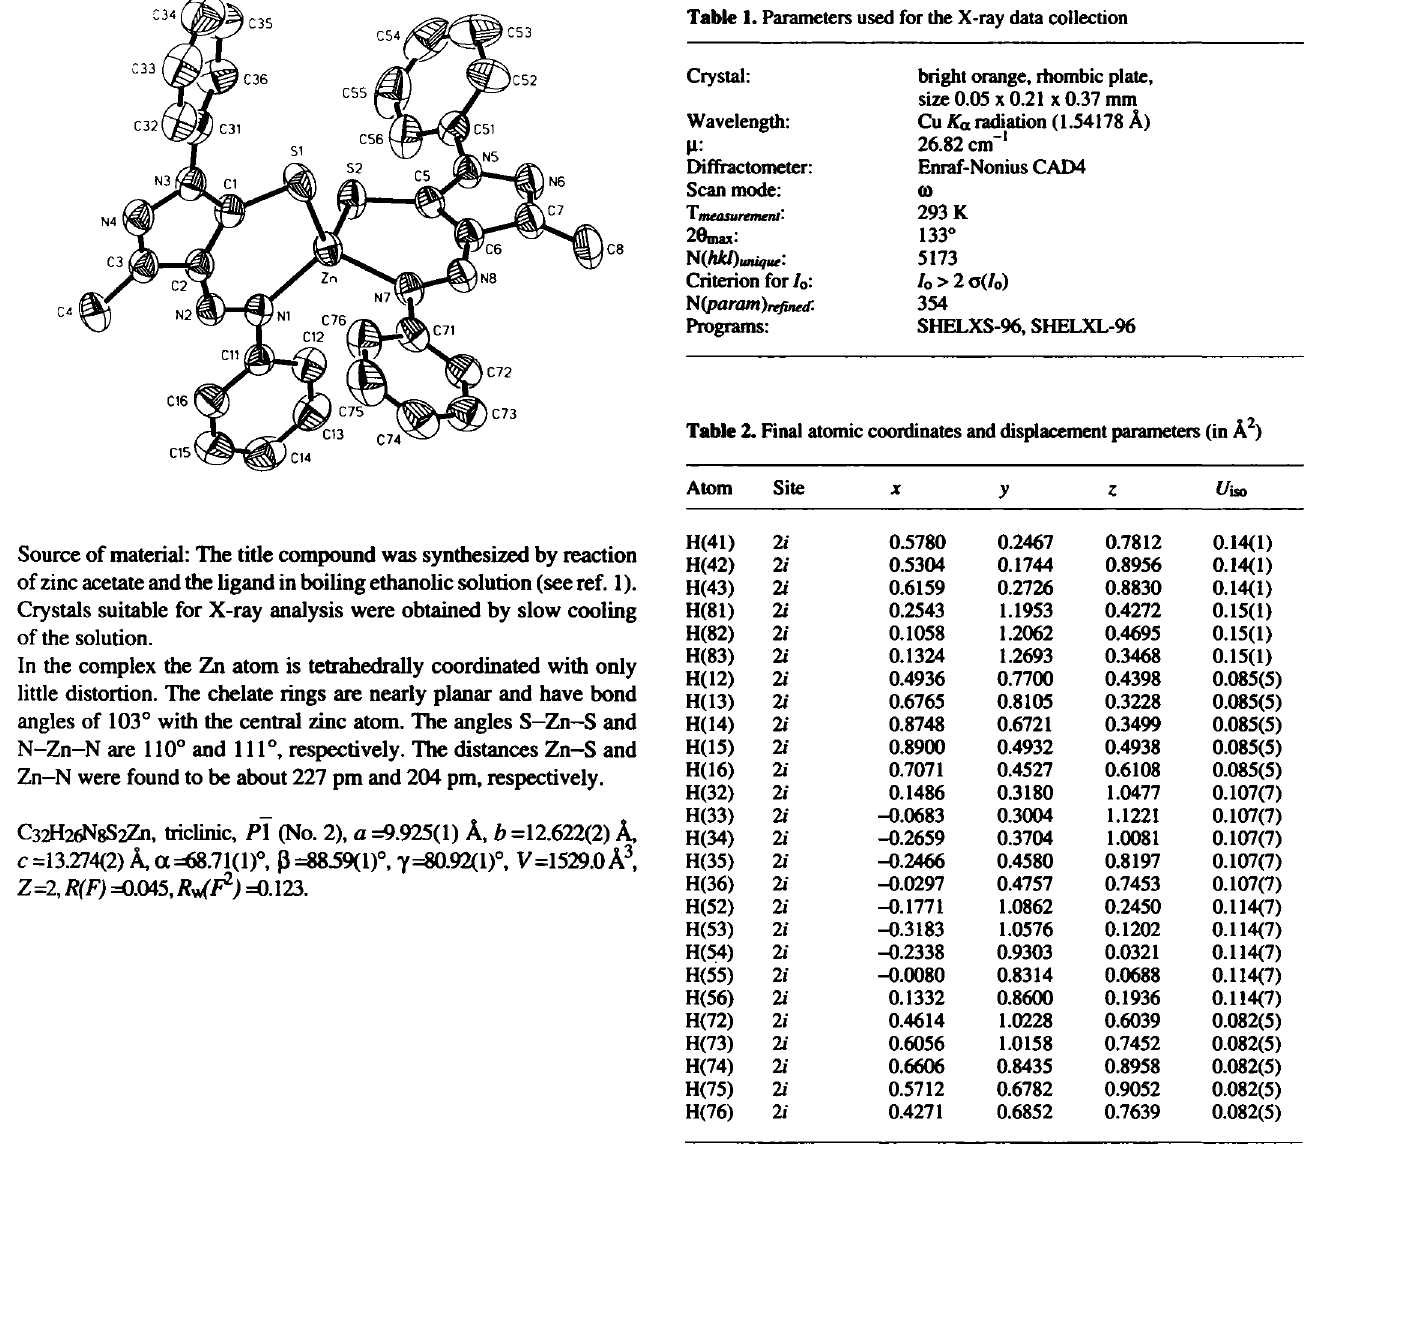
Table 1. Parameters used for the X-ray data collection Crystal: